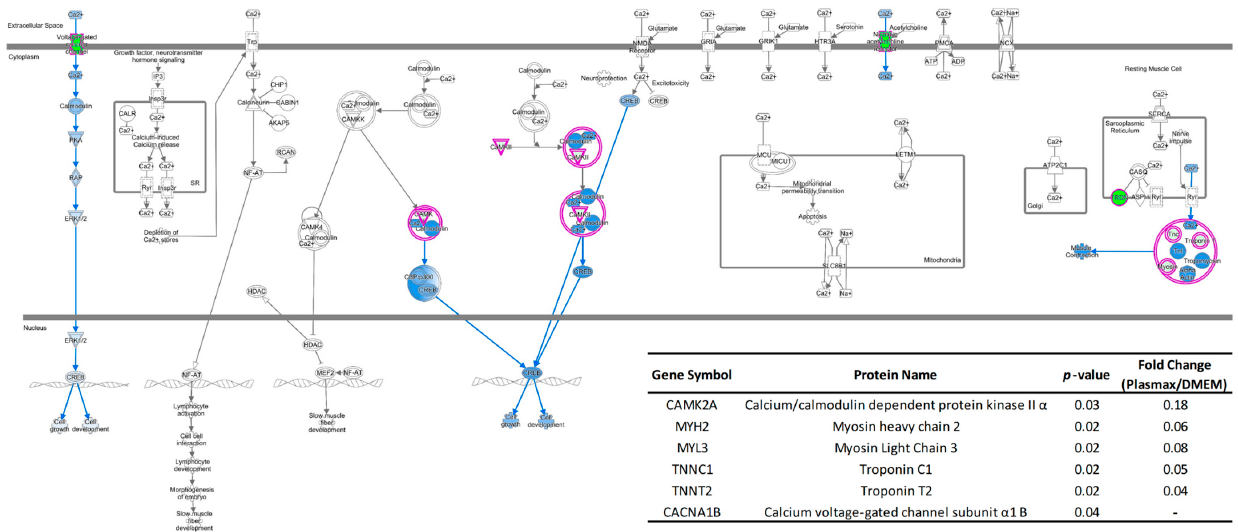
Figure 3. Inhibited calcium signaling pathway of CRL cell line cultivated by Plasmax compared to DMEM. Color codes and symbols are the same as Figure 2. The inset table provides the p -values and fold-change numbers of transcriptomes that are involved in this pathway.